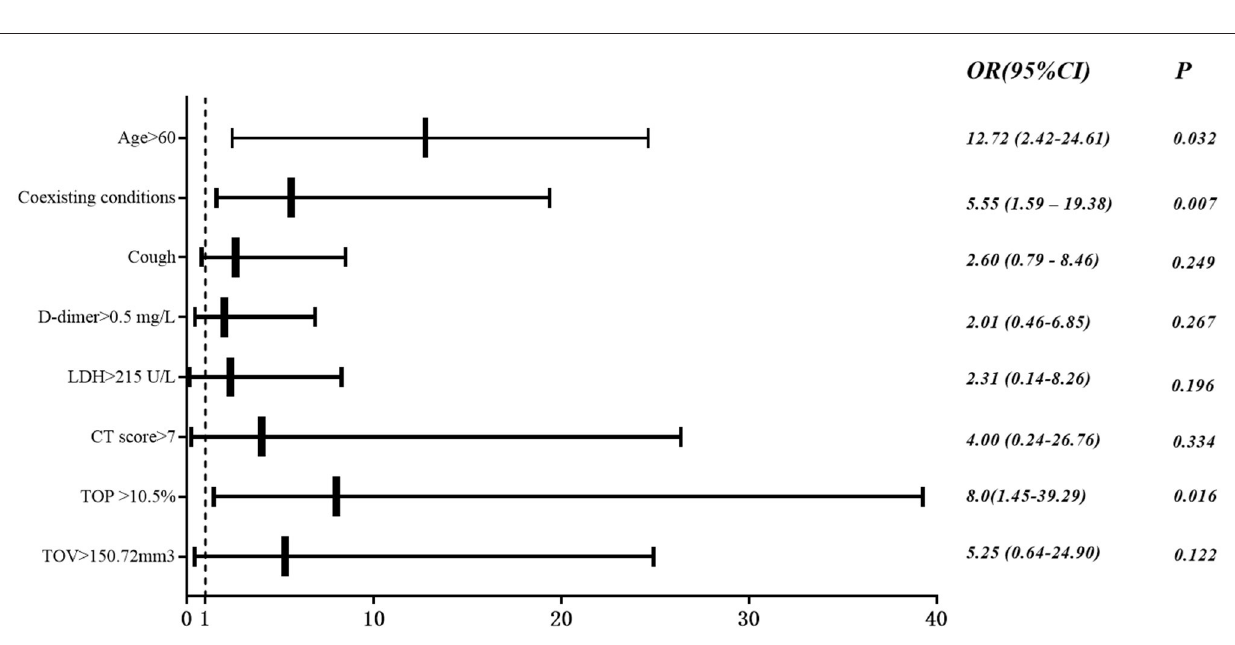
Frontiers in Public Health |